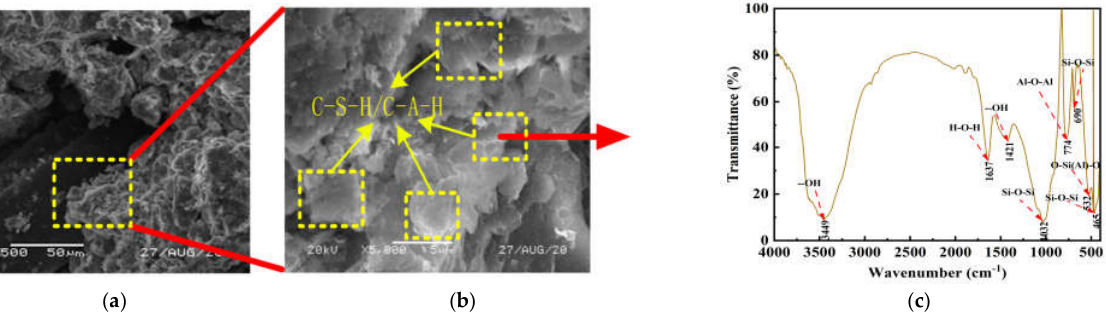
Figure 6. Microscopic analysis graphs of NFLS: ( a ) 500−fold SEM; ( b ) 5000−fold SEM; ( c ) FT−IR.